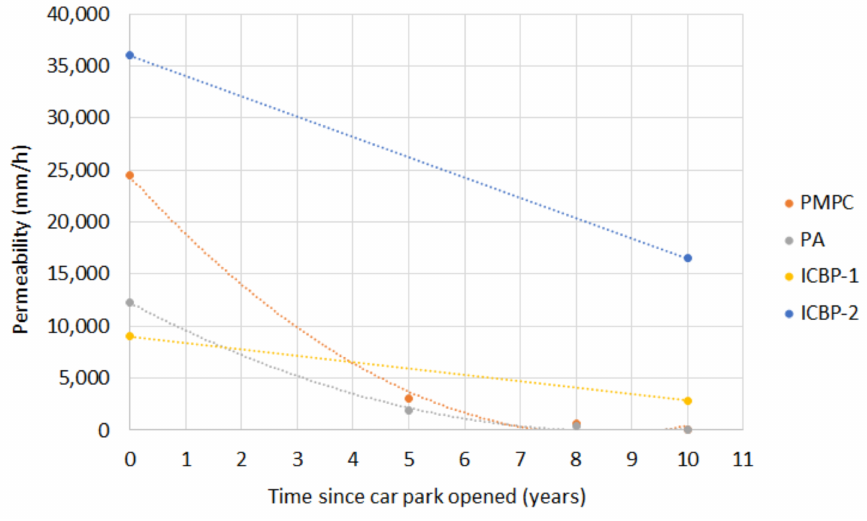
Figure 6. Evolution and trend lines for the permeability depending upon the PPS surface.